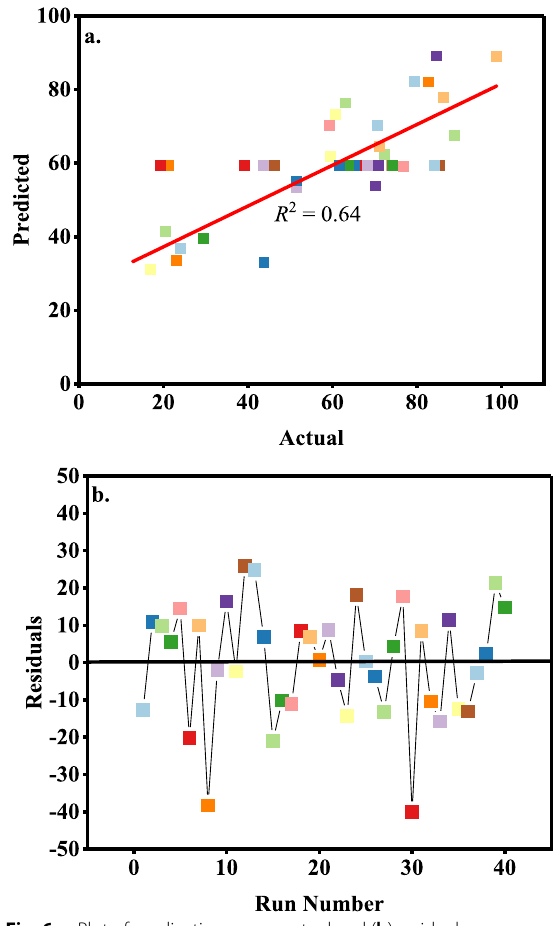
Fig. 6 a Plot of predication versus actual and ( b ) residual versus